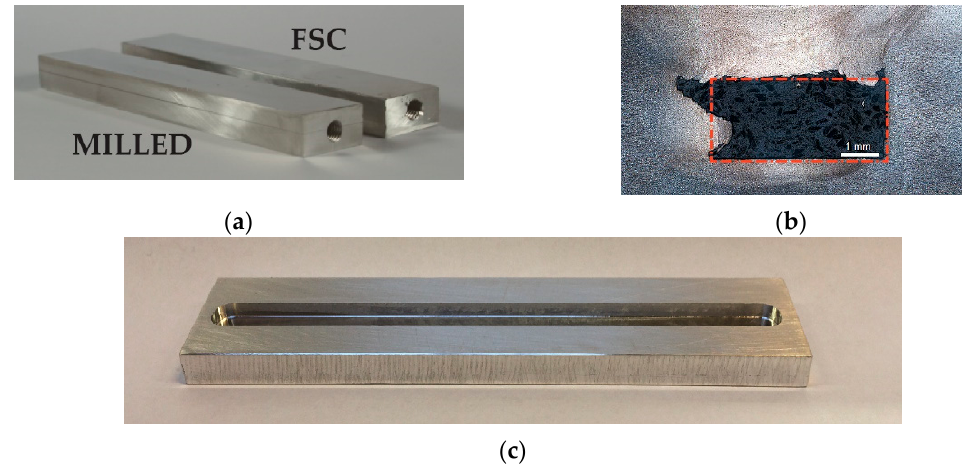
Figure 9. Milled and FSC samples: ( a ) The finished milled sample and the FSC sample are identical from the outer surface; ( b ) Outer sample dimensions are 10 (thickness) x 20 (width) x 110 (length) mm and the channel length is 100 mm when end fittings are excluded from outer dimensions. The cross-section from Figure 7 are used to define the size and width-height aspect ratio for the milled channel. The milled 6 × 2.5 mm channel is projected on top; ( c ) Case study: milled sample with channel visible. The lid was adhesively bonded afterwards with thermal epoxy. The adhesive seam thickness is < 0.1 mm. Table 3. Dimensions of AA5083-H111 cooling plate test samples and internal channels.